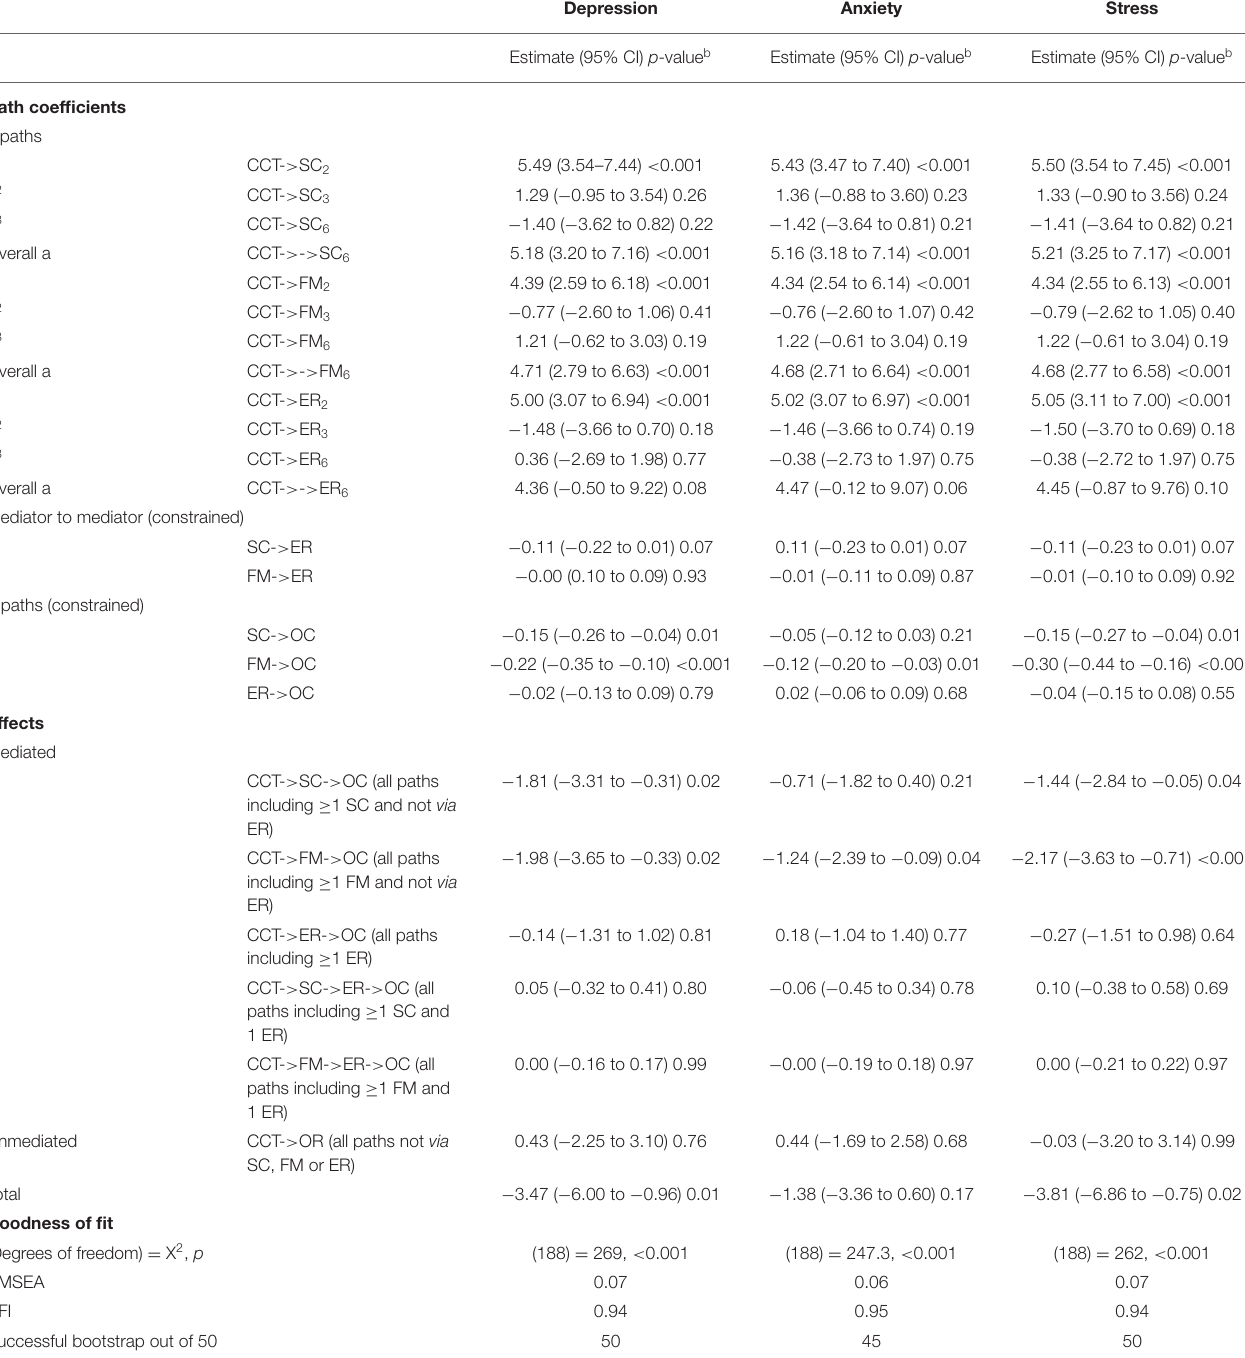
a According to Figure 2 . b Adjusted for sex, age, educational level, years as informal caretaker, schizophrenia (diagnosis, loved ones), anxiety (diagnosis, loved ones). SC, Self-Compassion Scale-12, Neff; FM , Five-Facet Mindfulness Questionnaire-15; ER, Cognitive Reappraisal, The Emotion Regulation Questionnaire; OC, outcome.